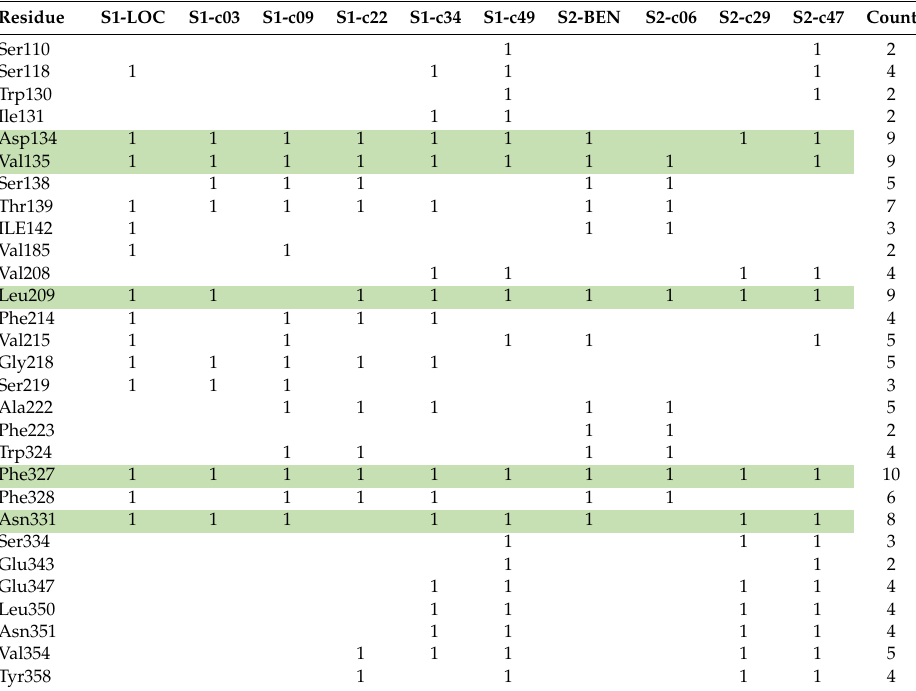
Table 3. Common ligand-binding residues of selected ligands. 1: the existence of a contact between the residue (rows) and the ligand (columns) if any atom of the residue and ligand lies within 4 Angstroms of each other. Green-colored rows indicate residues of especial interest, discussed in